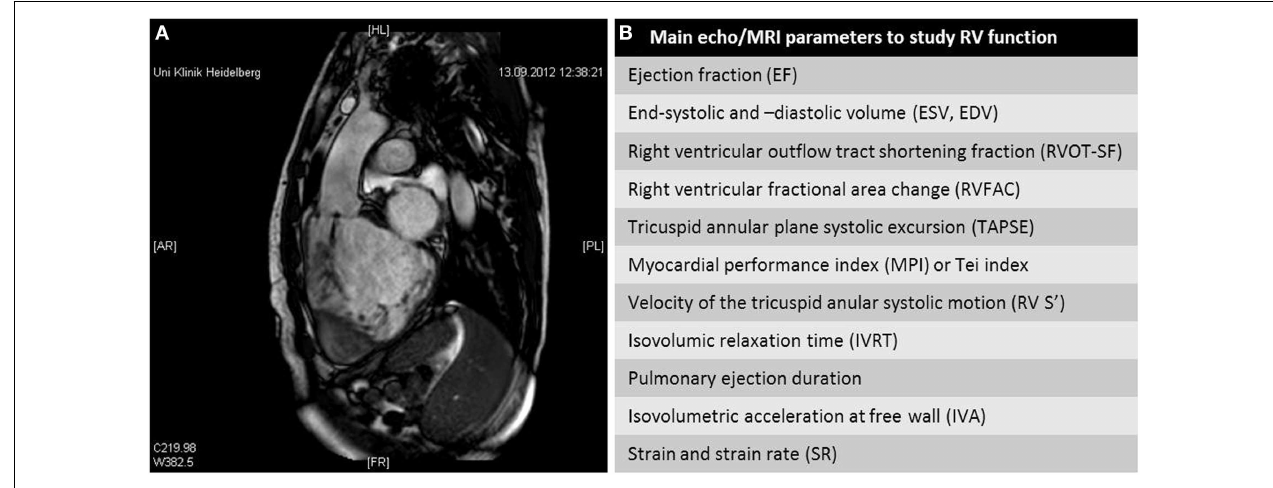
FIGURE 1 | (A) Magnetic resonance imaging scan of a patient with ccTGA and dilatation and dysfunction of the systemic right ventricle. (B) Main echocardiographic and MRI parameters to study the function of the right